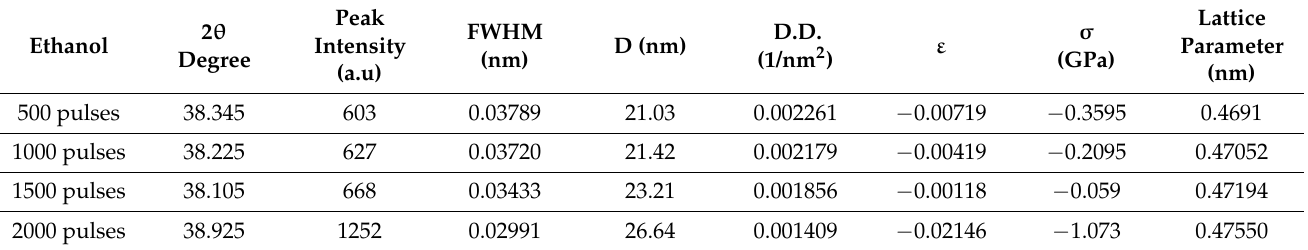
Table 2. The variations in peak intensity, FWHM, CS, D.D, lattice stain, residual stresses, and lattice parameter of Cd after ablation with KrF excimer laser for 500, 1000, 1500, and 2000 laser pulses at a constant fluence value of 3.6 Jcm − 2 in